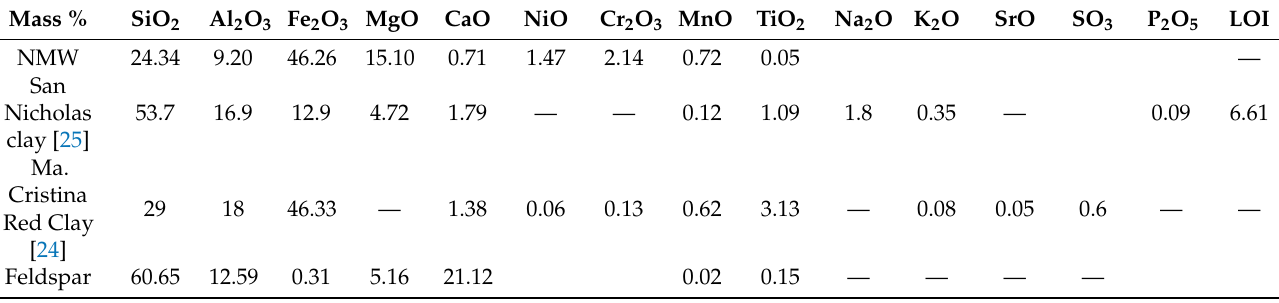
Table 1. Chemical composition of NMW and Feldspar.